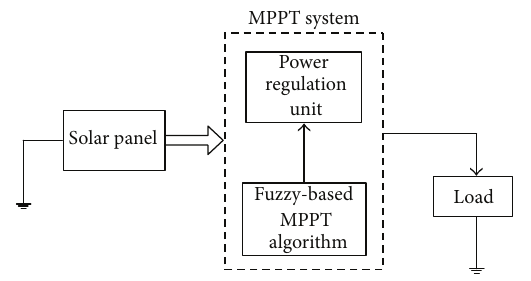
Figure 1: Block diagram of the proposed constant power